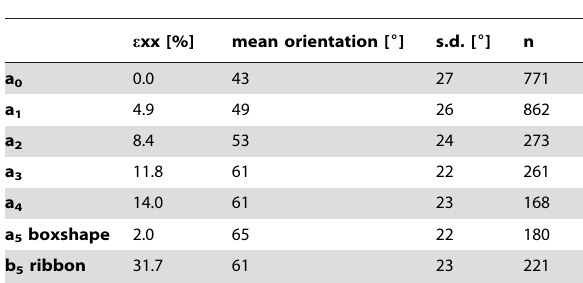
Table 2. Mean cell